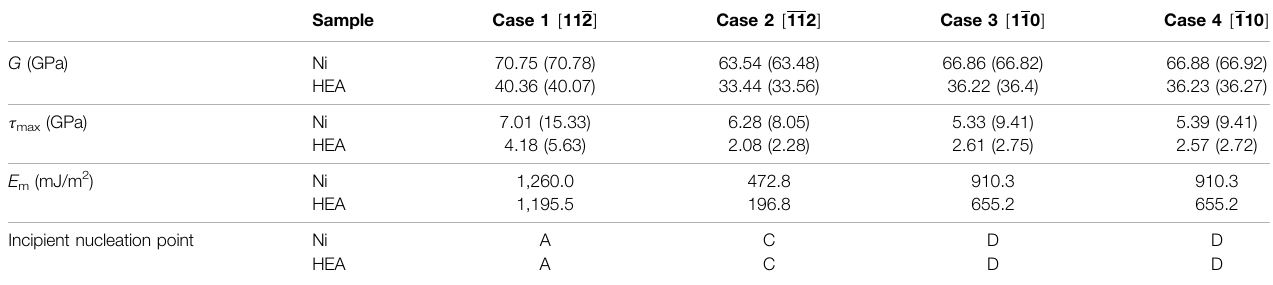
TABLE 1 | Shear moduli ( G ), critical shear stresses ( τ max ), energy barriers ( E m ) and incipient nucleation points of Ni and CoCrFeNiMn HEA samples with a SFT under shear along different directions. The results of samples without SFT are provided in brackets ( ) for